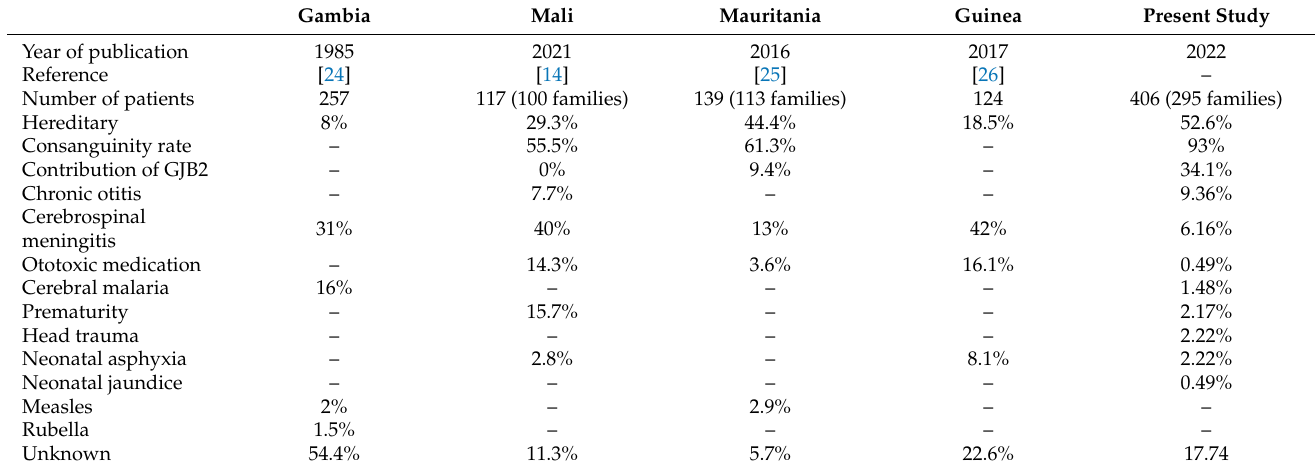
Table 5. Comparison of our results to other studies in the neighboring countries of Senegal. Gambia Mali Mauritania